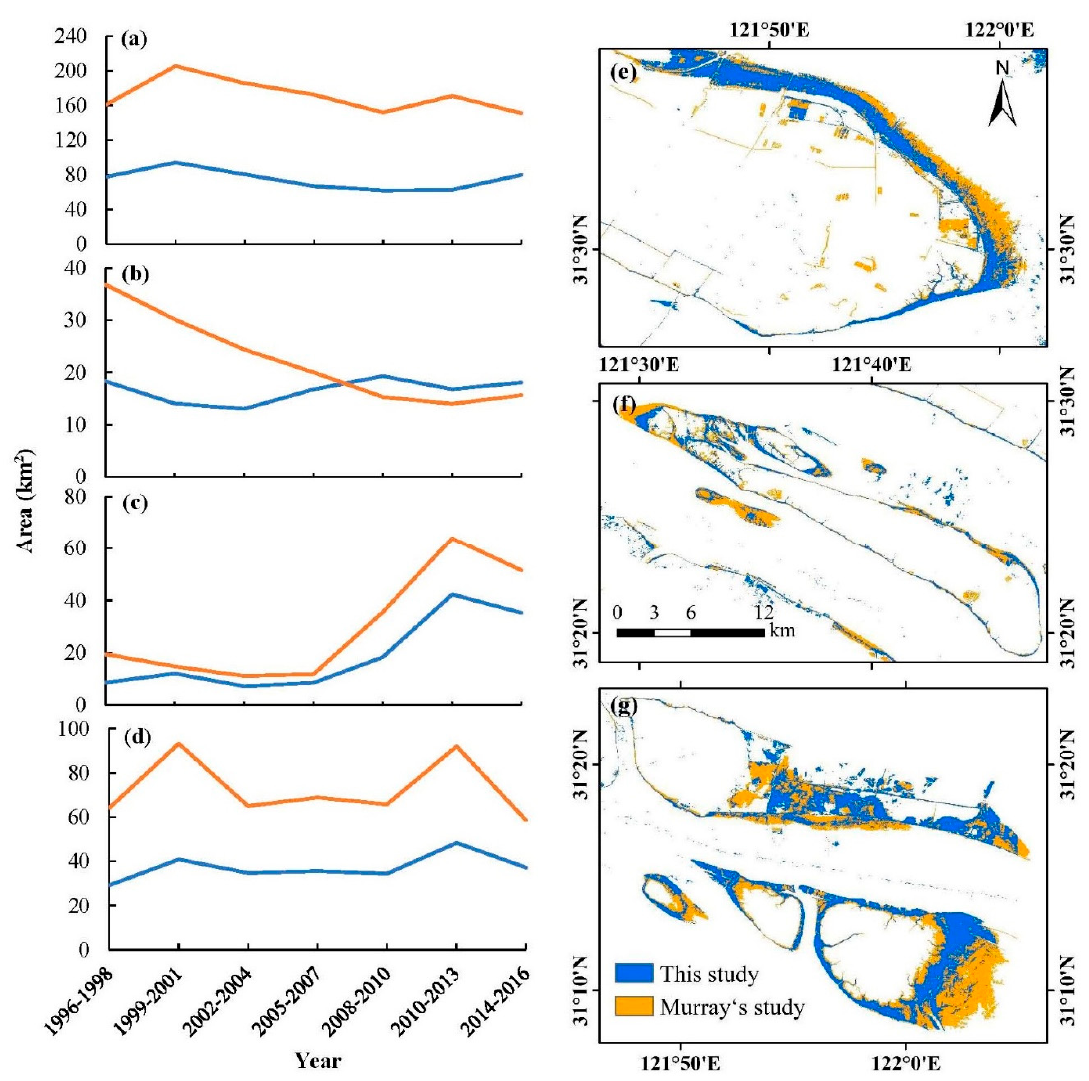
Figure 11. Area comparison of tidal flats with Murray’s research [8] in ( a ) CMI, ( b ) CXI, ( c ) HSI, and ( d ) JDSI, with details of differences during ( e ) 2014–2016, ( f ) 1996–1998, and ( g ) 2010–2013, respectively.